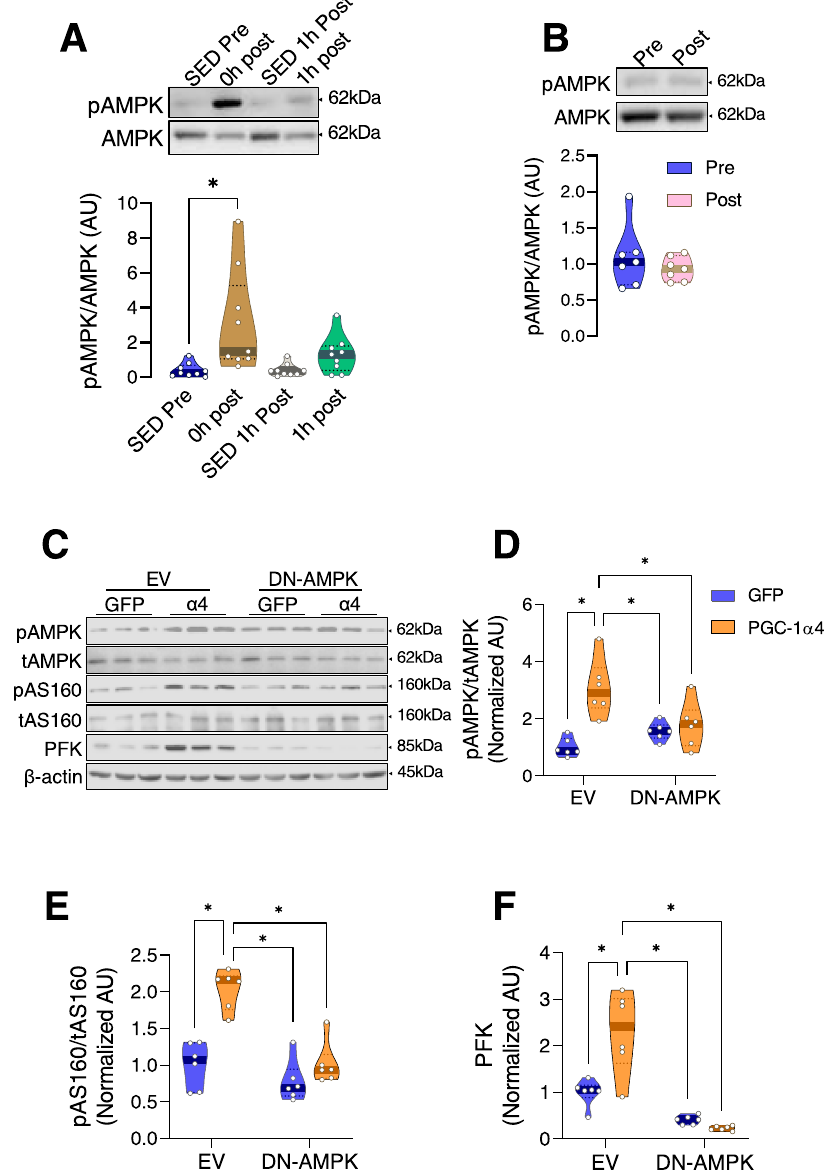
Fig. 6 The in fl uence of PGC-1 ɑ 4 on muscle glycolysis is AMPK dependent. A , B Representative immunoblots and quanti fi cation of phosphorylated AMPK in human muscle obtained after an acute resistance exercise bout ( A ) or after RET ( B ). One-way ANOVA was used with multiple comparisons for panel A , and paired two-tailed t -test was used for panel B . Data are expressed as the phosphorylation of each signaling protein normalized to the abundance of its total protein content ( n = 9 for acute RE, n = 7 for RET). C – F Representative immunoblots and quanti fi cation of AMPK, AS160, and PFK in cells transfected with GFP or PGC-1 α 4 after EV or DN-AMPK transduction are shown. Data are expressed as the phosphorylation of each signaling protein normalized to the abundance of its total protein content and PFK was normalized with β -actin ( n = 6 per group). One-way ANOVAs were used with multiple comparisons * P < 0.05 versus empty vector (EV). Values are expressed as individual data points. Signi fi cant labeled P -values in each panel from left to right are as follows: panel A = 0.013; panel D = < 0.001, 0.005, and 0.033; panel E = < 0.001, <0.001, and <0.001; panel F = 0.006, <0.001, and